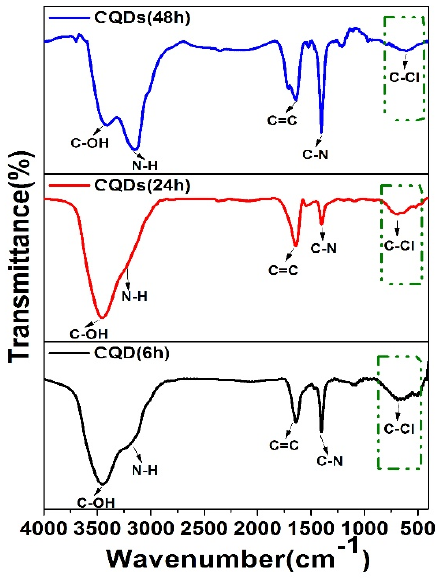
Figure 12. FTIR spectra of CQDs (6 h), CQDs (24 h) and CQDs (48 h).